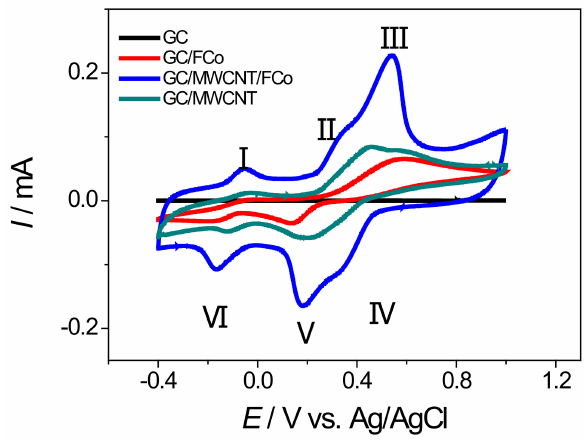
Figure 5. Cyclic voltammograms in the presence of noradrenaline 10 mmol L − 1 in phosphate buffer 0.1 mol L − 1 (pH = 7) with a scan rate of 100 mV s − 1 of GC (——), GC/ FCo 98 (——), GC/MWCNT (——), GC/MWCNT/FCo 98